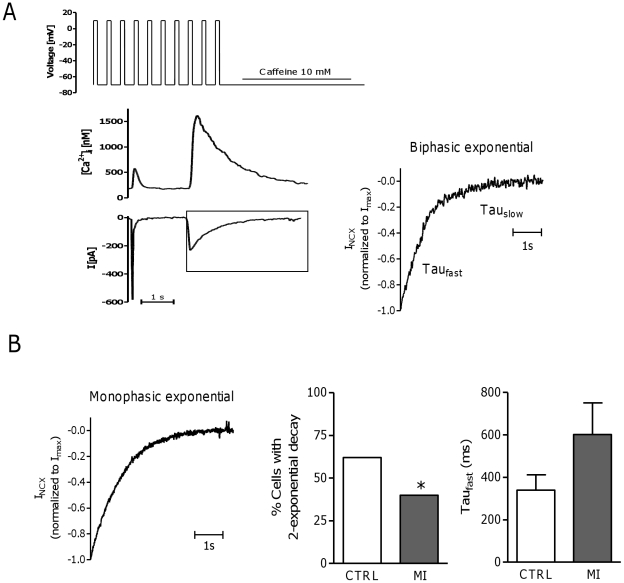
Ca2+ removal by NCX during caffeine application.A. Example of current and [Ca2+]i transient recording obtained during the last conditioning pulse from -70 to +10 mV and caffeine application (left). The decay of the current was fit by a 1- or 2-exponential according to the goodness of fit (R2>0.95) and with the 2 amplitudes being negative. The right panel is a typical example of a 2-exponential decay in a CTRL myocyte. B. Example of monophasic INCX decay (left) and mean data on incidence of biphasic decay (middle). The percentage of cells better fit by a biphasic exponential was significantly higher in CTRL than in MI (CTRL, Npigs = 4, ncells = 17; MI, Npigs = 4, ncells = 12, P<0.05). In addition, Tau of fast component of INCX decay tended to be faster in CTRL than in MI (right, CTRL, Npigs = 4, ncells = 8, vs. MI, Npigs = 2, ncells = 4, P = NS). * denotes P<0.05.